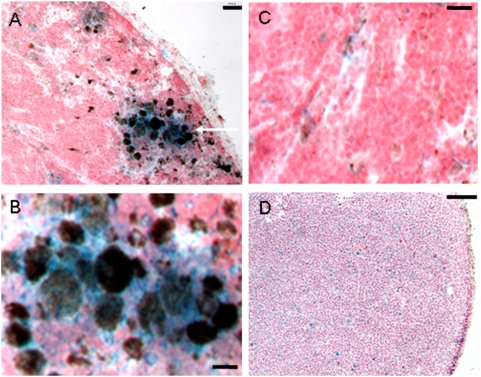
Histologic analysis of lymph nodes after imaging showing metastatic and normal lymph nodes from mice injected with NV1023.(A) LacZ staining (blue) shows diffuse β-galactosidase transgene expression adjacent to metastatic B16-F10 melanoma cells (black cells, scale bar 30 µm). The white arrow indicates the area of micrometastases. (B) High magnification of the area in (A) indicated by the arrow showing diffuse LacZ staining in the area of metastases (scale bar 10 µm). (C) High magnification of a positive lymph node showing non-specific LacZ stain in an area devoid of melanoma cells. (D) Low magnification of a normal lymph node from an animal treated with NV1023. Only a non-specific LacZ staining is seen (scale bar 130 µm).